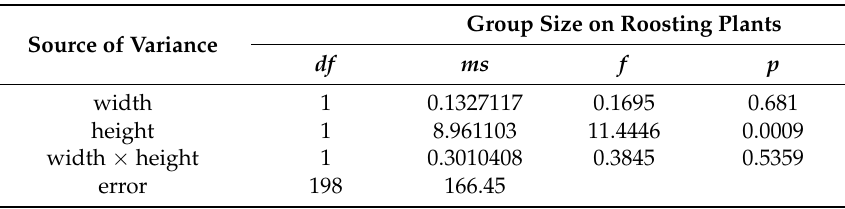
Table 3. Two-way analysis of variance for group size of gregarious nymphs of Schistocerca gregaria considering the influence of plant width and